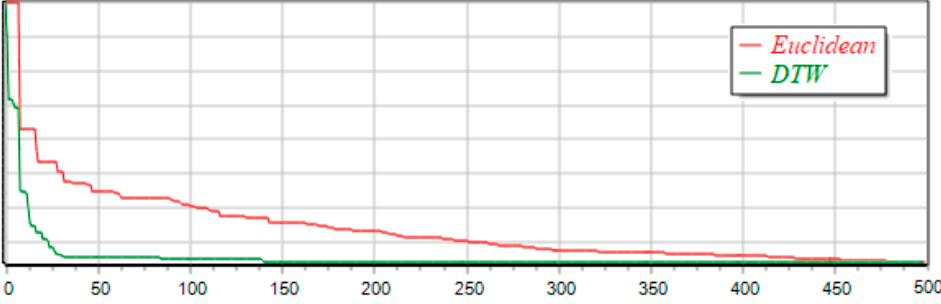
Figure 6. Comparison of the objective function vs. generations with the Euclidean norm (red curve) and DTW algorithm (green curve).